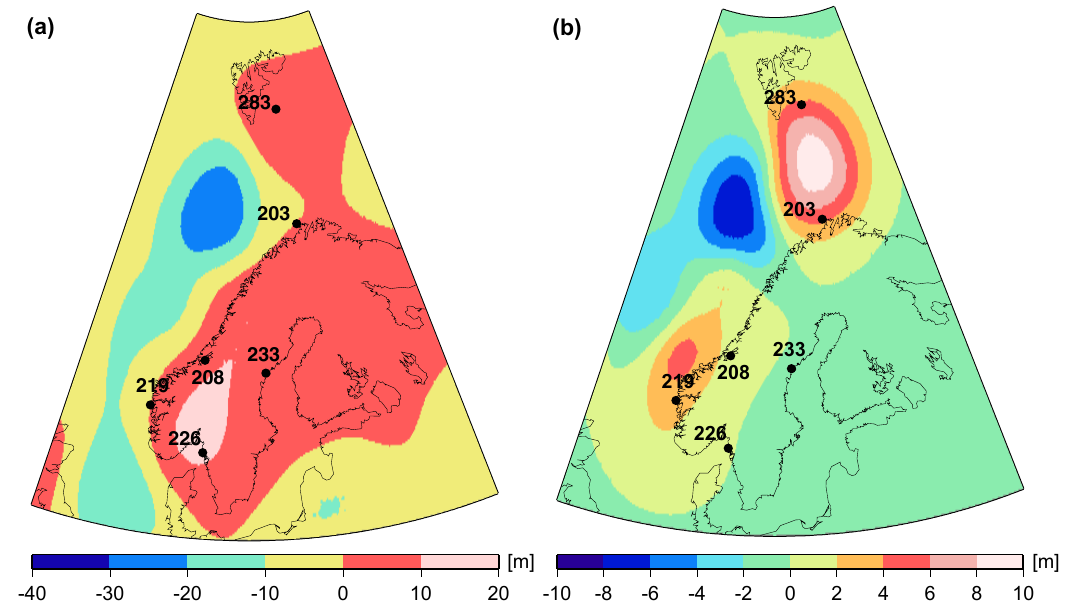
Figure 3. Colors denote the difference between RSL computed for the LGM (26kyr BP in the ICE-5G model) and computed for the present caused by GISR for sediment models Amantov (a) and Sed1 (b) . Note the different color scales. Numbered black dots show the locations of the relative sea level data used in Fig. 7. Earth model M4-16-80 is used for both cases.